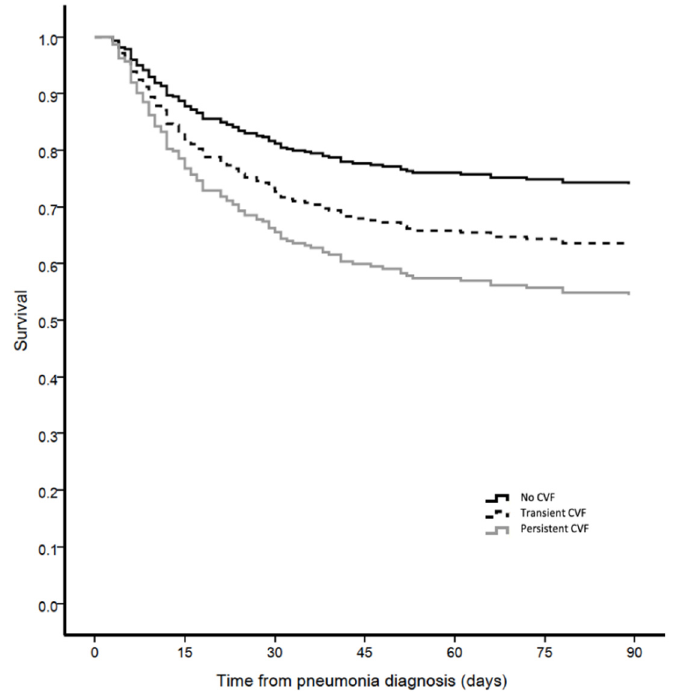
Figure 1. Adjusted survival curve for 90-day mortality in accordance with the presence of cardiovascular failure in patients with ICUAP.